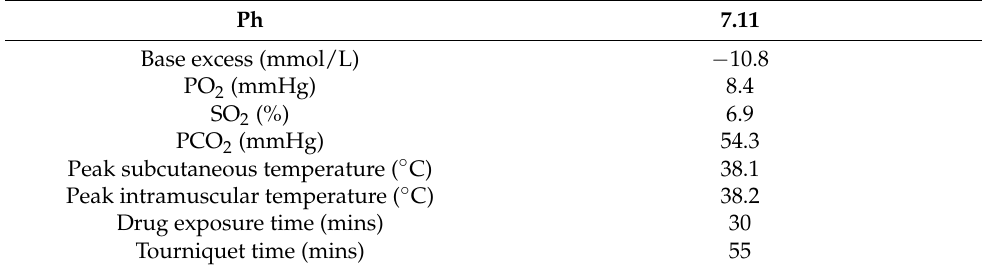
Table 1. Median intra-operative values at 30 min upon completion of ILI in 185 patients at Melanoma Institute Australia [13].